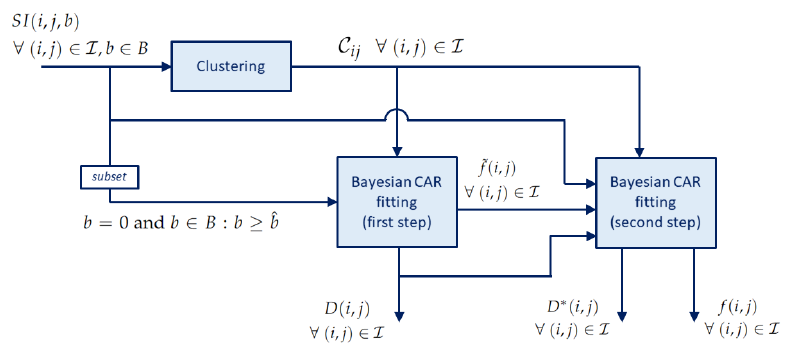
Figure 1. Block diagram of the IVIM fitting procedure with